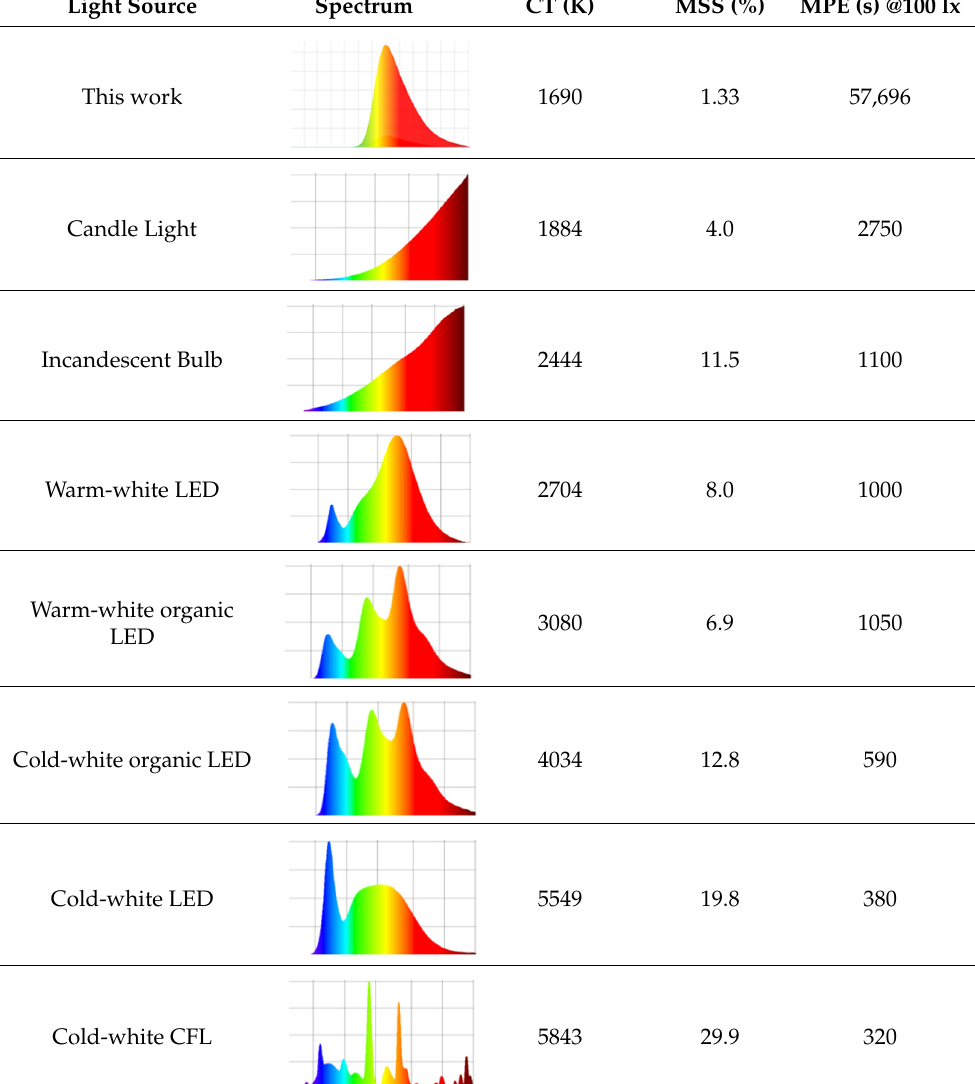
Table 4. Comparison between the spectrum (350–780 nm), color temperature (CT), melatonin suppression sensitivity (MSS) (1.5 h exposure), and maximum permissible exposure limit (MPE) of the studied very low color temperature candlelight organic LED and the commercial luminaires. Light Source